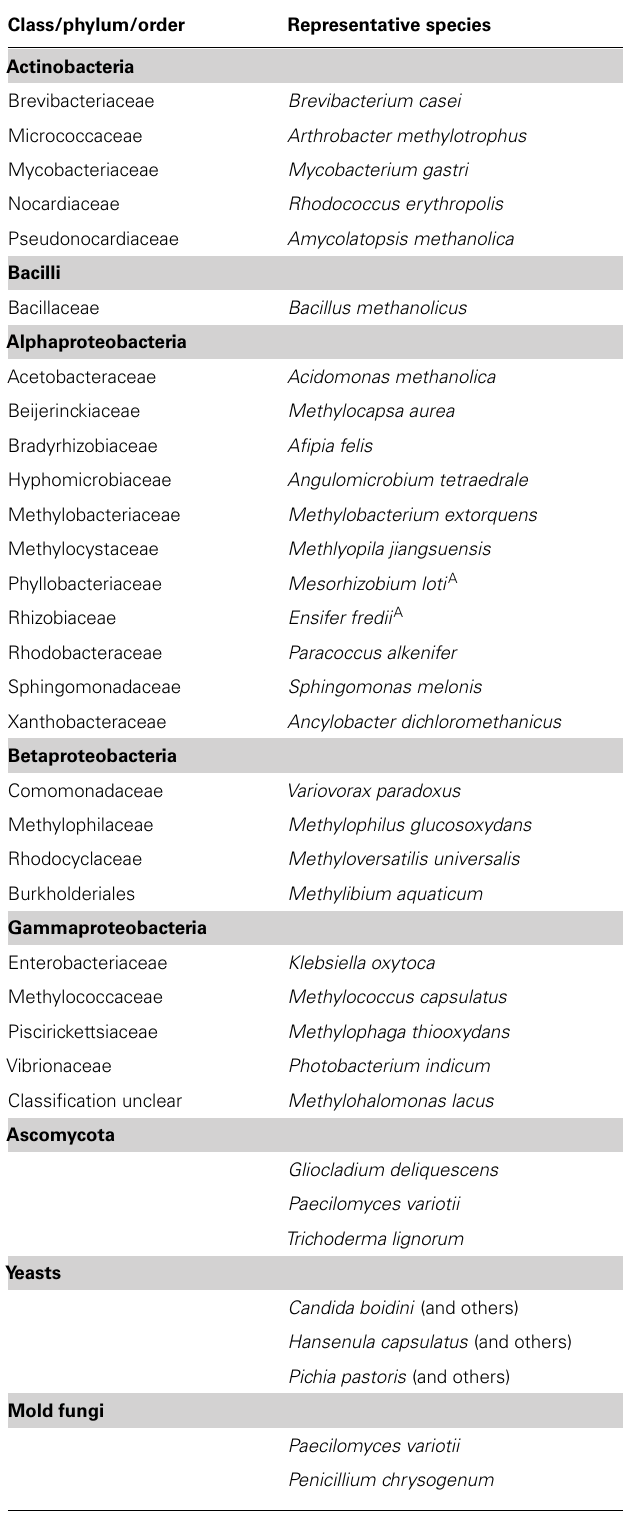
Table 1 | Classes and phyla of Bacteria and fungi that contain methanol-utilizing methylotrophs based on previous reviews (Kolb, 2009a; Gvozdev etal.,